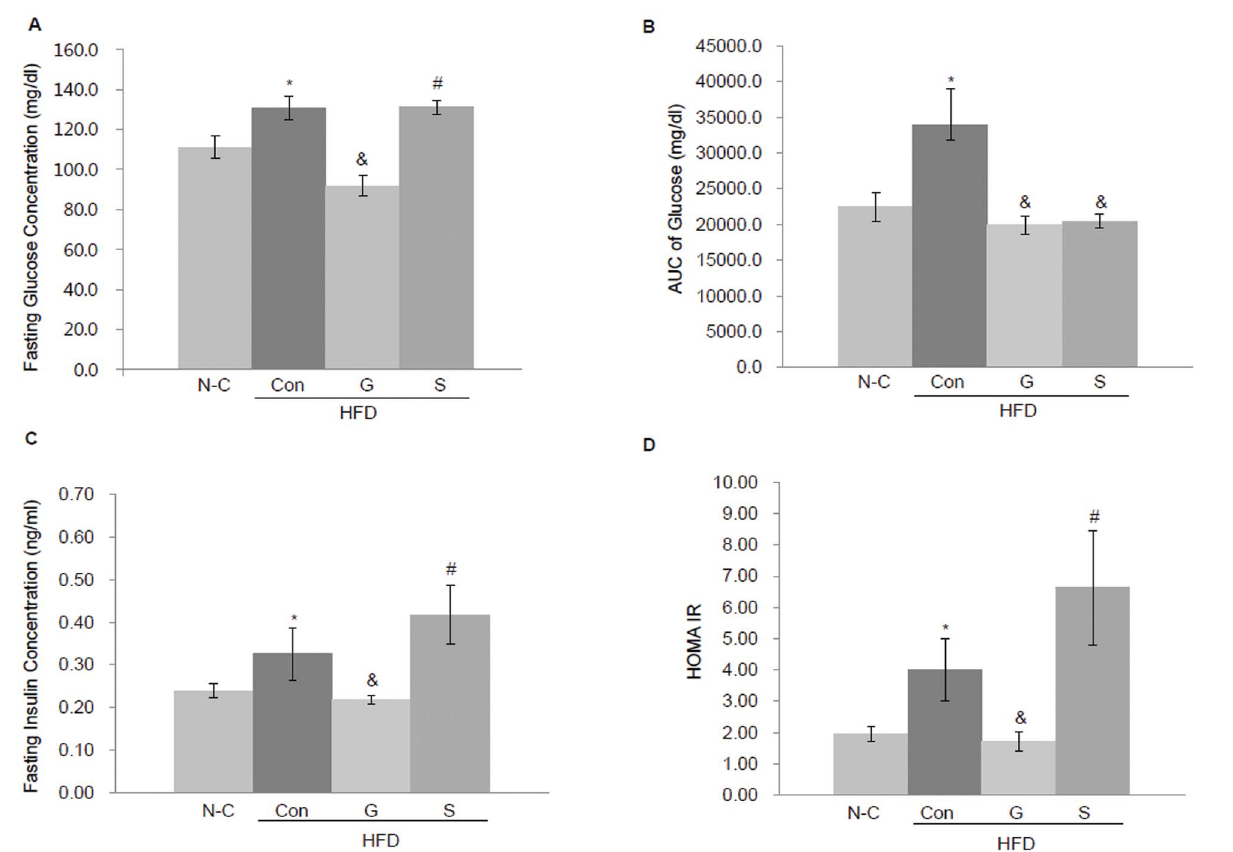
Fig. 2. Glucose and insulin tolerance analyses. Changes in glucose and insulin concentrations after 6 weeks of gefitinib or statin treatment. (A) Fasting glucose concentration. (B) AUC for glucose levels following oral glucose tolerance test. (C) Fasting insulin concentration. (D) The insulin resistance index HOMA-IR. n 5 10 each. Values represent the means ¡ SEM. * P , 0.05 relative to N-C, & P , 0.05 relative to Con (high-fat diet only group), # P , 0.05 relative to G (gefitinib plus high-fat diet group). N-C, normal control; HFD, high-fat diet; Con, control; G, gefitinib; S, statin.